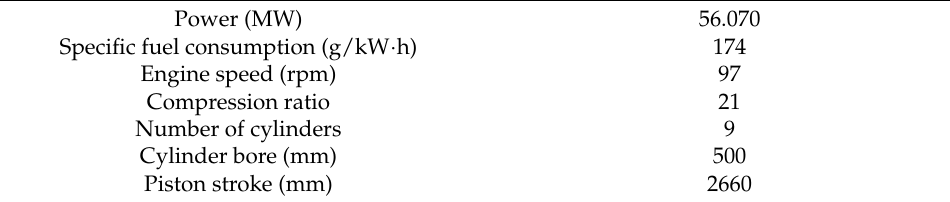
Table 3. Two-stroke diesel engine parameters.